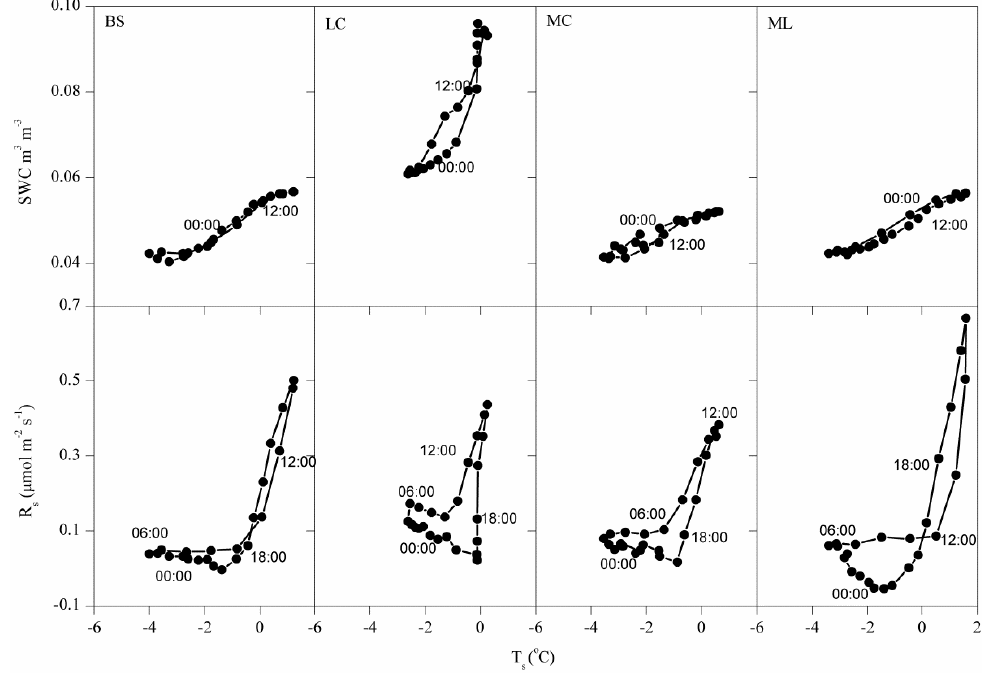
Figure 5. Mean diurnal soil respiration (R s ) and soil water content (SWC) in relationship to soil temperature (T s ) on days with freeze-thaw cycles, for four microsites including bare surface (BS), lichen crust (LC), moss crust (MC), and mixed crust of both moss and lichen (ML).